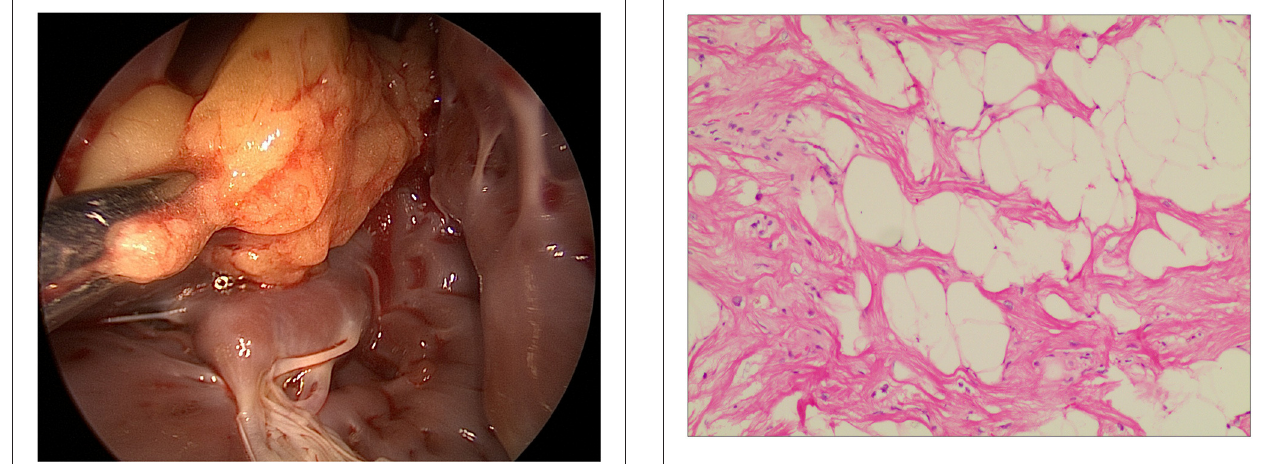
FIGURE 3 | Mediastinoscope image via a left atriotomy showing a yellowish well-encapsulated mass within the left ventricle.